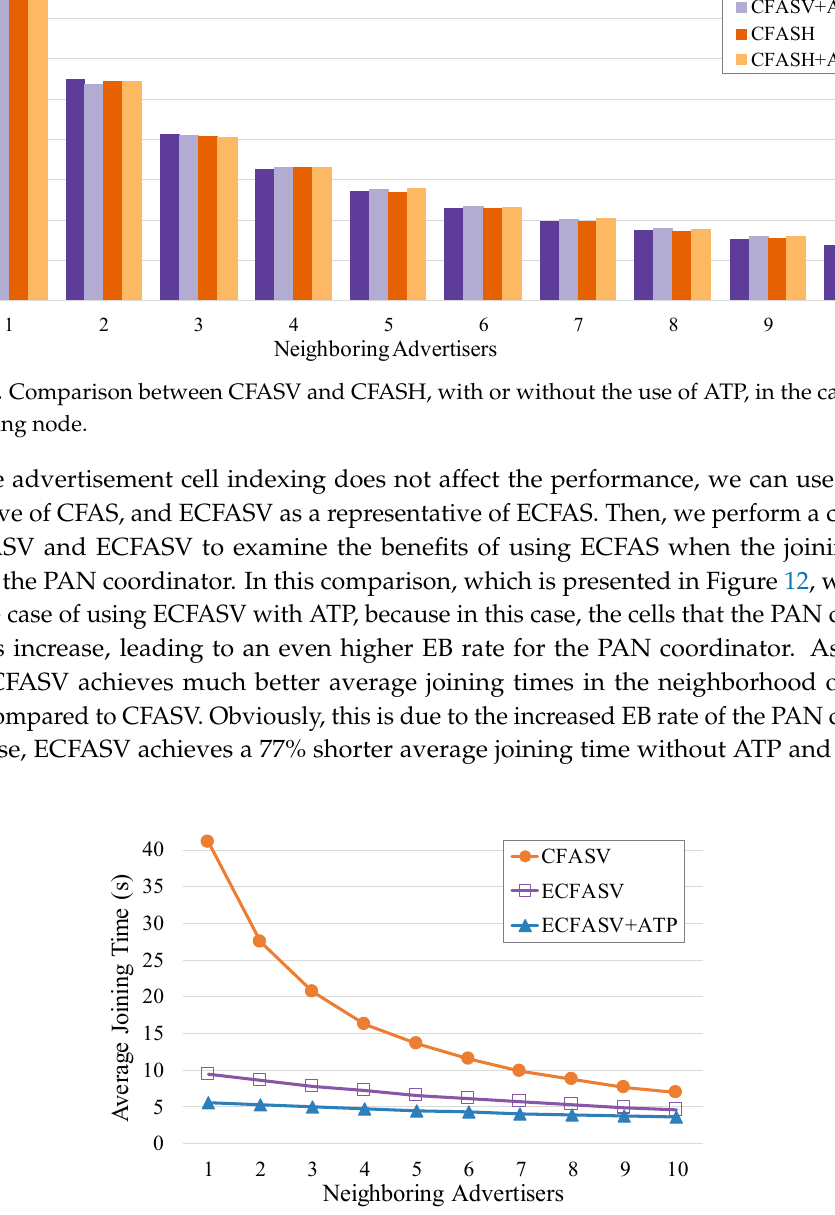
Figure 12. Comparison between CFASV and ECFASV when the joining node is a fixed neighbor of the PAN